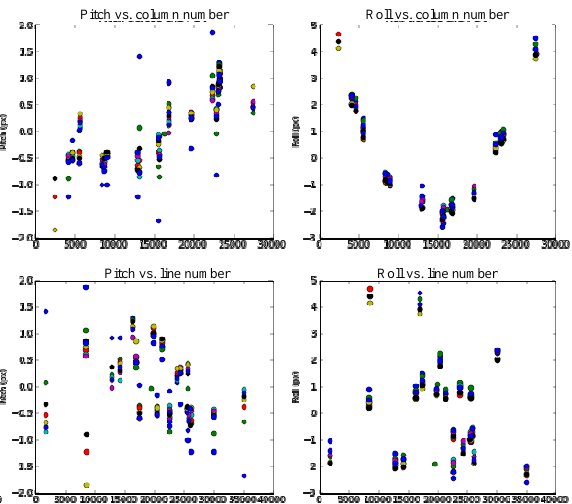
Figure 14 : Geometrical effects